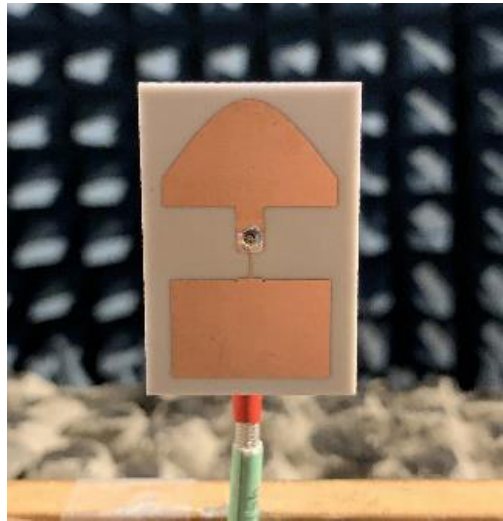
Figure 4. Prototype of the 2 × 1 building block.